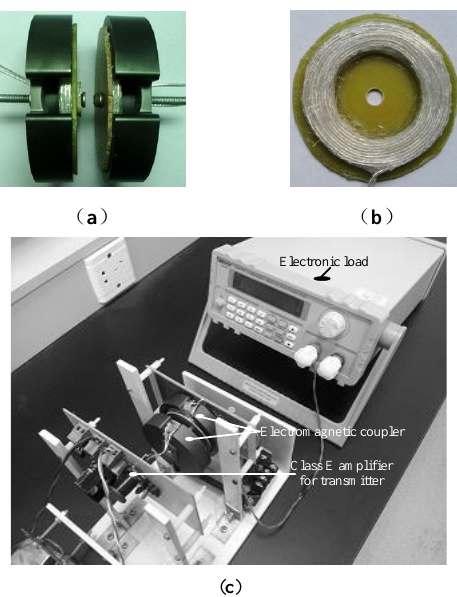
Figure 9. Prototype of the coupler and ECPTC: ( a ) Electromagnetic coupler; ( b ) Coils of the coupler; ( c ) Prototype.